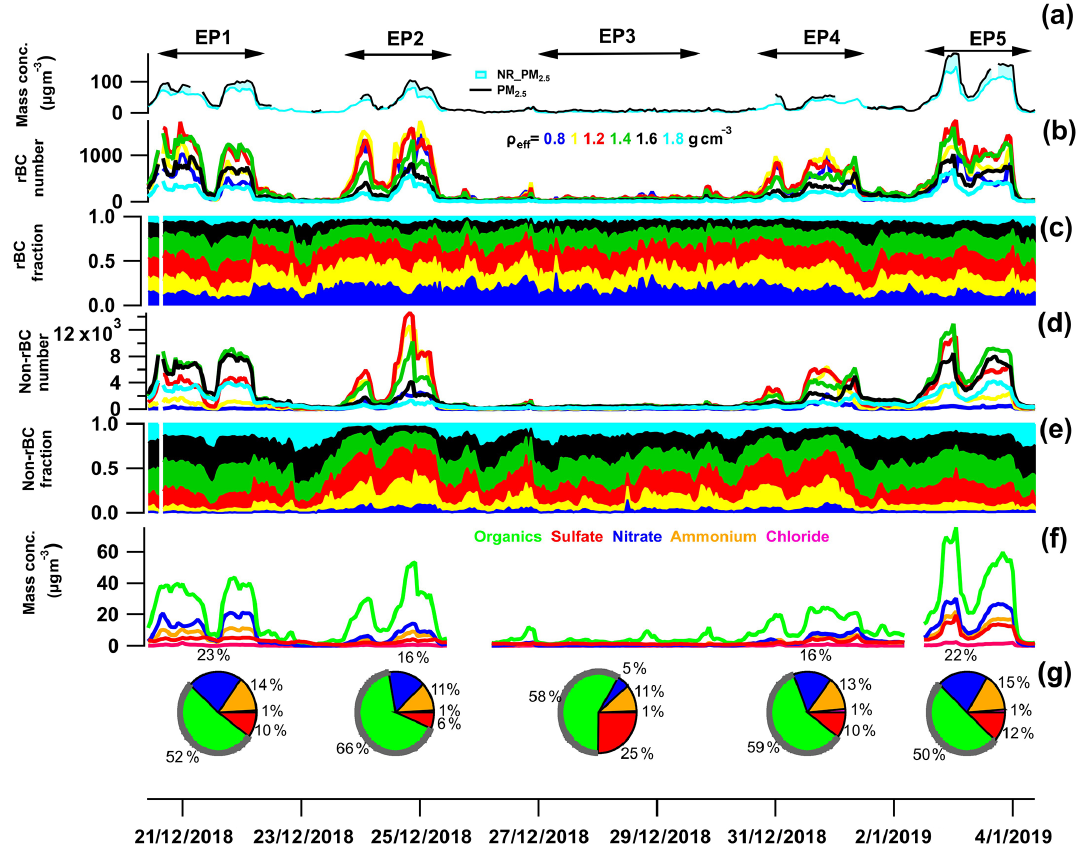
Figure 1. Time series of (a) the PM 2 . 5 mass concentration; (b) number counts of rBC-containing particles with different effective densities; (c) number fractions of rBC-containing particles with different effective densities; (d) number counts of non-rBC particles with different effective densities; (e) number fractions of non-rBC particles with different effective densities; (f) mass concentrations of aerosol species, including organics, sulfate, nitrate, ammonium, and chloride, in NR-PM 2 . 5 ; and (g) mass fractions of aerosol species in NR-PM 2 . 5 during the five episodes denoted at the top of the